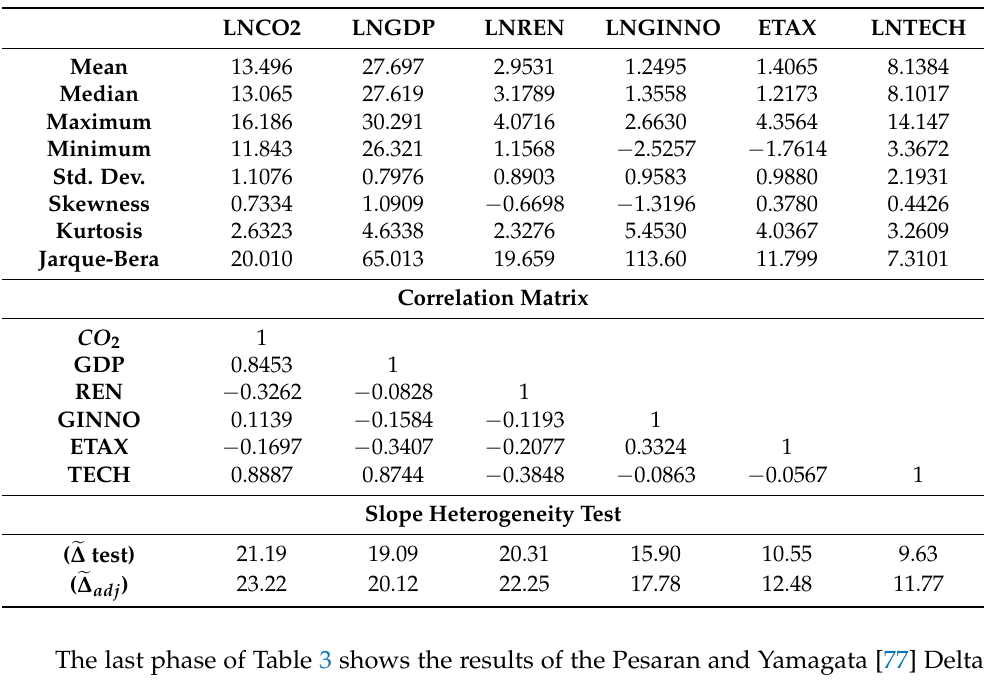
Table 3. Descriptive and Correlation